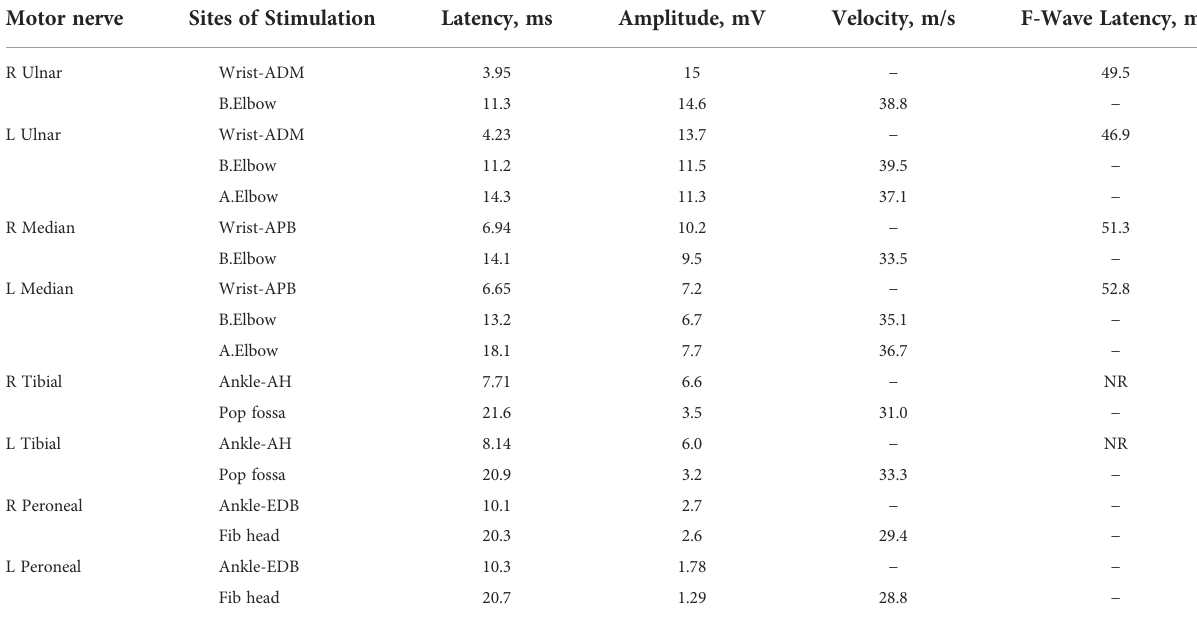
TABLE 2 Motor nerve conduction.